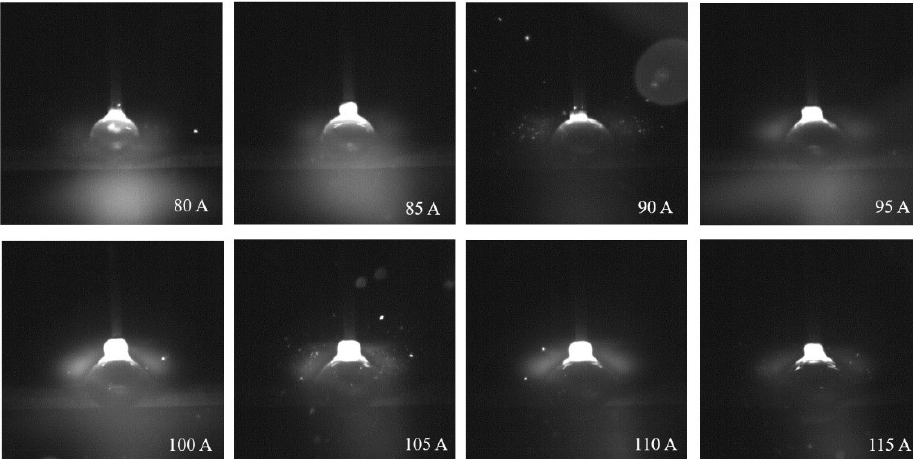
Figure 15. The spreading effect of the molten pool under different currents.